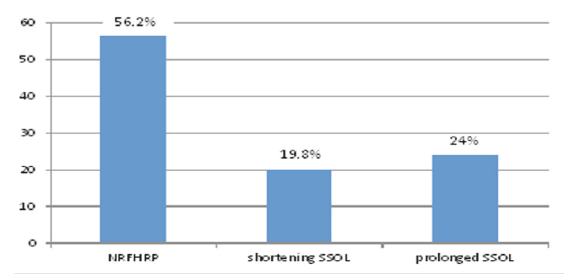
Figure 1: Proportion of indications for OVD among mothers who gave birth by OVD in JUMC December 1, 2016, to May 30,